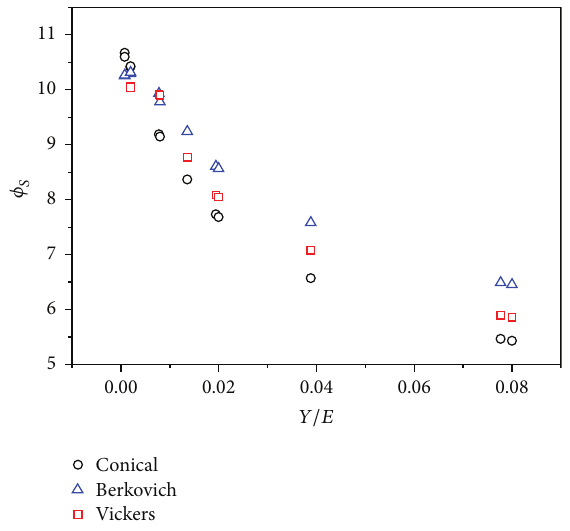
Figure 8: The variation of dimensionless function 𝜙 𝑆 = 𝑆/(𝐸ℎ) with respect to 𝑌/𝐸 for different kinds of indenters.